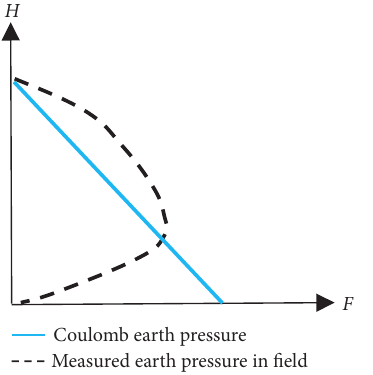
Figure 2: Active Earth pressure against rigid wall of limited soil mass (revised from Fan et al.